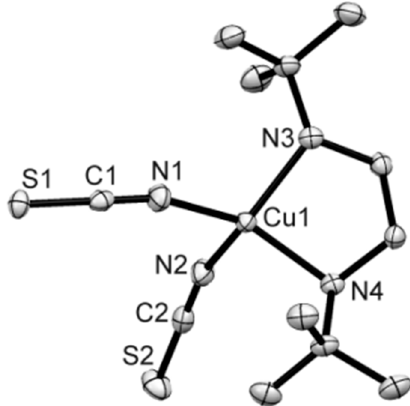
Figure 5. Molecular plot of 5 (50% probability ellipsoids). Selected bond distances (Å) and angles (°): Cu(1)–N(1) 1.9378(17), Cu(1)–N(2) 1.9303(17), Cu(1)–N(3) 2.0102(16), Cu(1)–N(4)